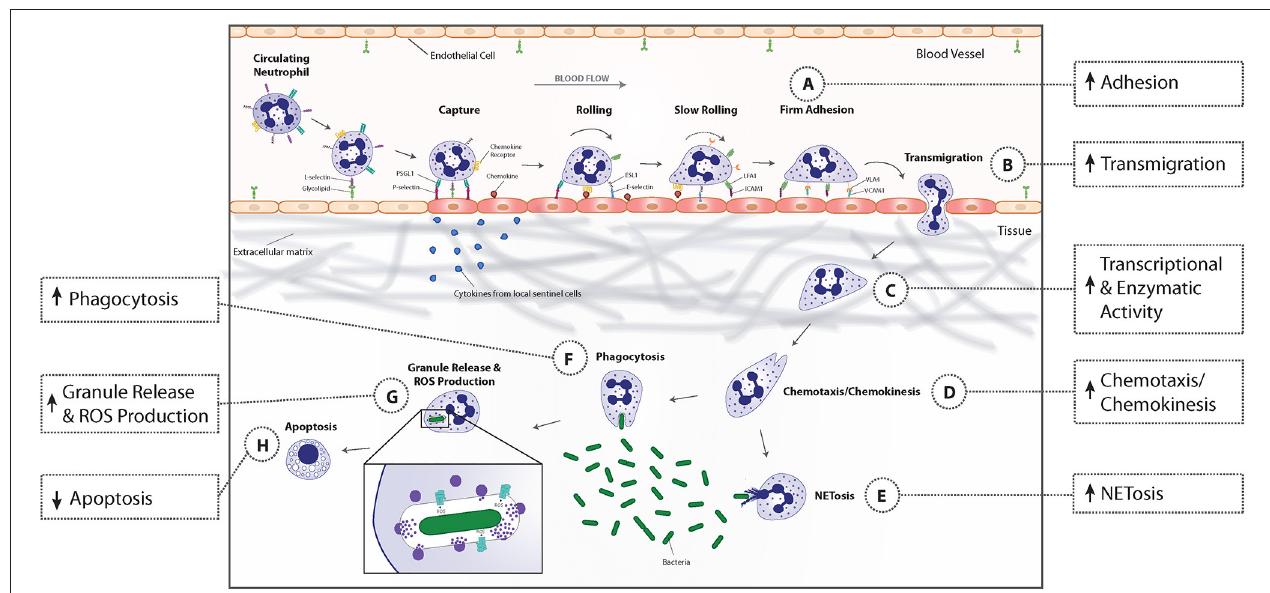
FIGURE 1 | Priming-associated phenotypic changes and their effect on neutrophil functional responses. Neutrophils in circulating blood are in a resting state, characterized by a round morphology, non-adherence, minimal transcriptional activity, and a limited capacity to respond to activating stimuli. Microbial entry into tissues or tissue injury induces local immune cells to release pro-inflammatory cytokines that modify endothelial cell adhesion molecule profile and enter the bloodstream to begin priming neutrophils. Upon exposure to these priming agents, neutrophils undergo an increase in enzymatic and transcriptional activity that results in activation and synthesis of inflammatory mediators and enzymes that mediate downstream phenotypic and functional changes. Immediately, neutrophils begin to change their adhesion receptor pattern by shedding selectins, fusing secretory vesicles with the plasma membrane which leads to increased integrin expression, and a rapid increase in the gene expression of several surface receptors that allows newly primed cells to more rapidly adhere to endothelial cells (A). This phenotypic change coupled with the release of granules containing matrix metalloproteases, promotes neutrophil migration into inflamed tissues (B). The priming process continues when neutrophils bind to extracellular matrix proteins (C). Binding of neutrophil extracellular matrix receptors leads to an increase in actin polymerization, available receptors from secretory vesicle degranulation, and intracellular signaling that results in enhanced chemotaxis and chemokinesis (D). When primed neutrophils encounter bacteria, their phagocytic capacity is increased due to the upregulation in the number and affinity of receptors on the plasma membrane (F). By then, ROS production, granule release (G), and NET formation (E) have been primed to augment microbicidal activities. Finally, priming prolongs neutrophil lifespan by activating anti-apoptotic signal transduction pathways and transcription factors that decrease transcription of pro-apoptotic factors